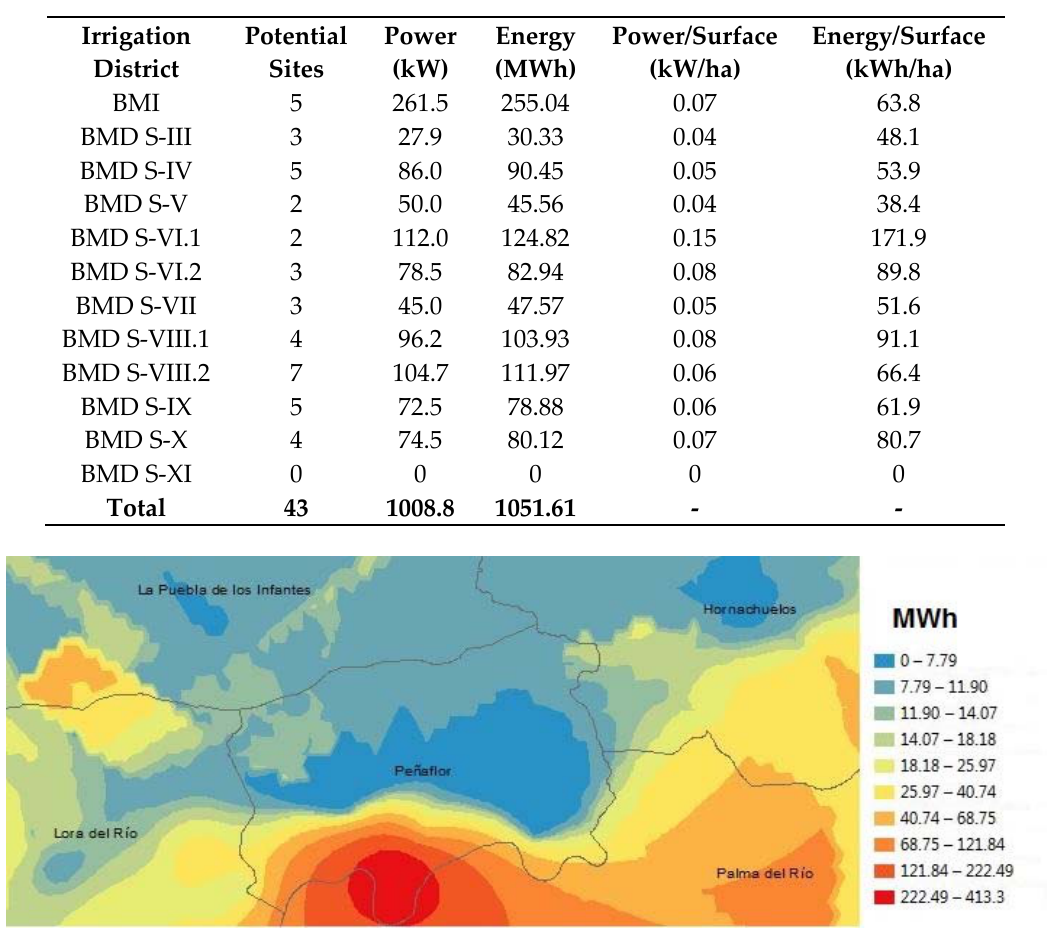
Table 2. Summary table of the results obtained for each irrigation network. Potential points where turbines could be installed, potential power, energy that could be recovered per annum and the parameters power available per surface unit (kW ha − 1 ) and energy that could be recovered per surface unit (kWh ha − 1 ).